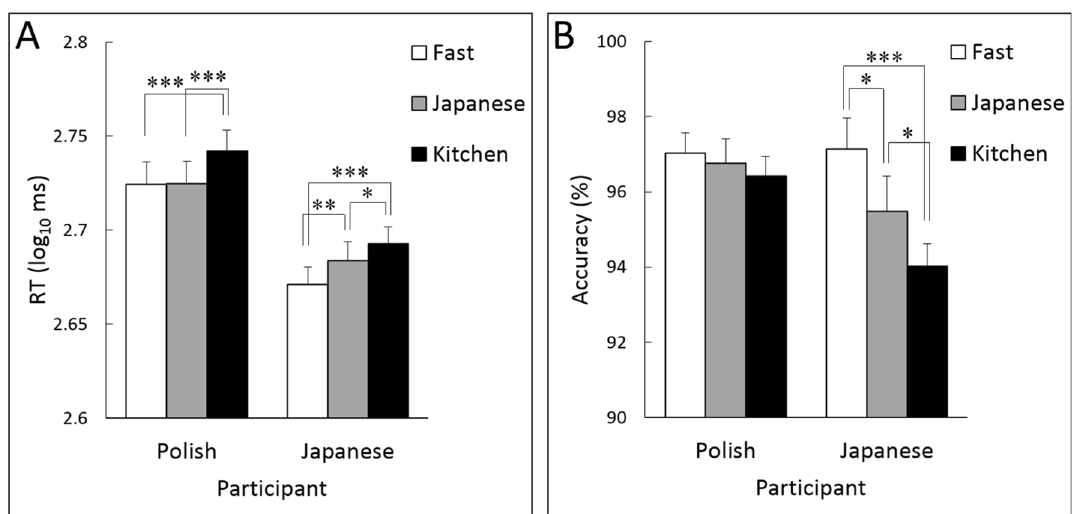
Figure 1. Mean (with SE ) reaction times (RTs) ( A ) and percent accuracy ( B ) for the detection of fast food, Japanese food, and kitchen tools by Polish and Japanese participants. *** p < 0.001; ** p < 0.01; * p <